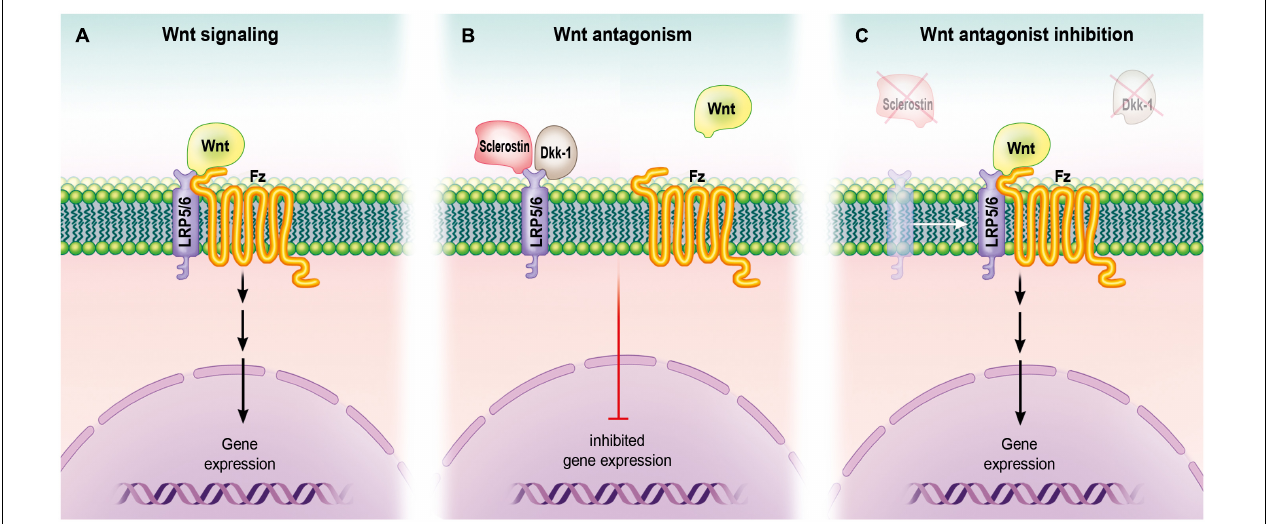
FIGURE 3 | Role of Wnt signaling in osteoblasts. (A) Upon binding to its receptor (Frizzled) and co-receptors (LRP5 and LRP6), Wnt activates their signaling pathway, leading to gene expression (and ultimately protein synthesis and the formation of bone). (B) Wnt antagonists sclerostin and Dkk-1 bind LRP5 and LRP6, preventing their interaction with Frizzled and resulting in inhibition of gene expression. (C) Loss-of-function mutation in a gene that encodes for a Wnt antagonist orpharmacological engagement of the antagonist with an inhibitory molecule such as an antibody can lead to inhibition of Wnt antagonism and promote gene